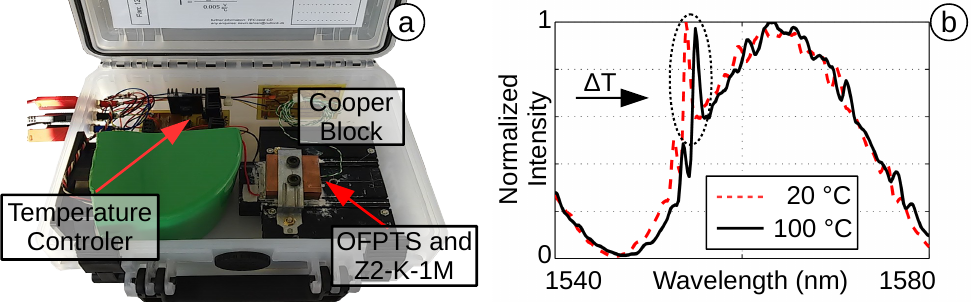
Figure 14. ( a ) Controlled temperature block; ( b ) FBG temperature